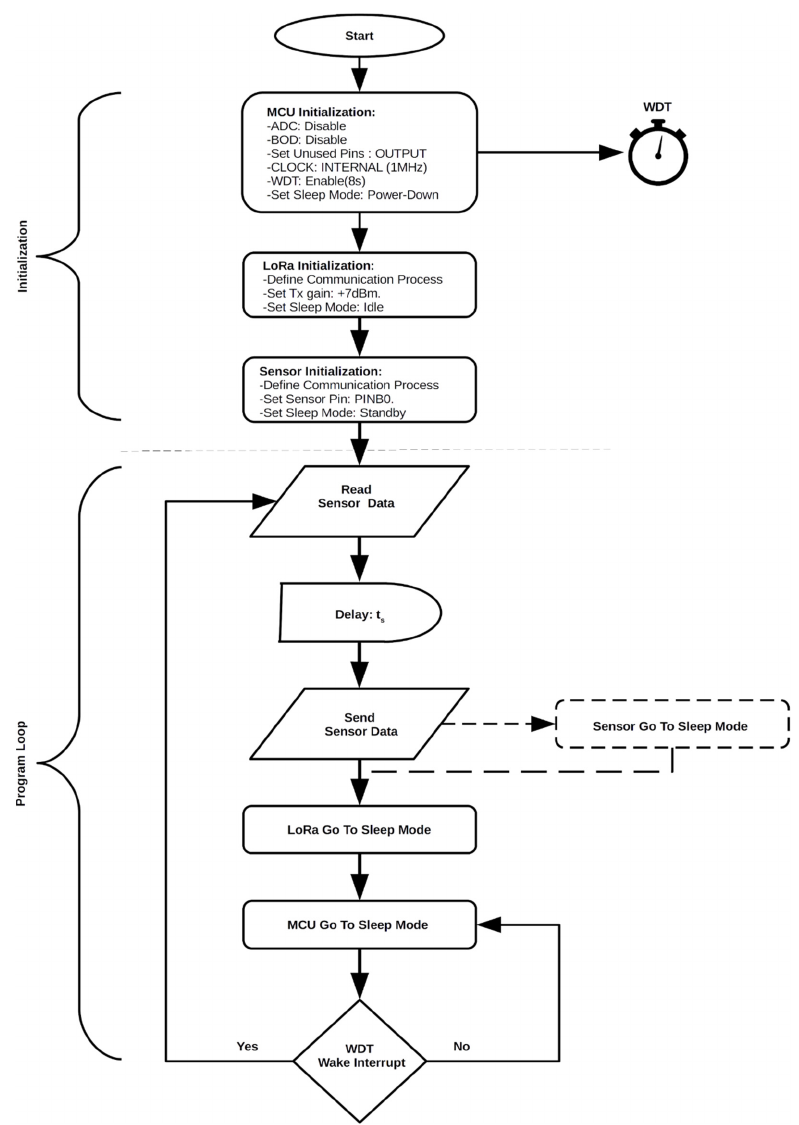
Figure 18. The proposed firmware-based power consumption flowchart.